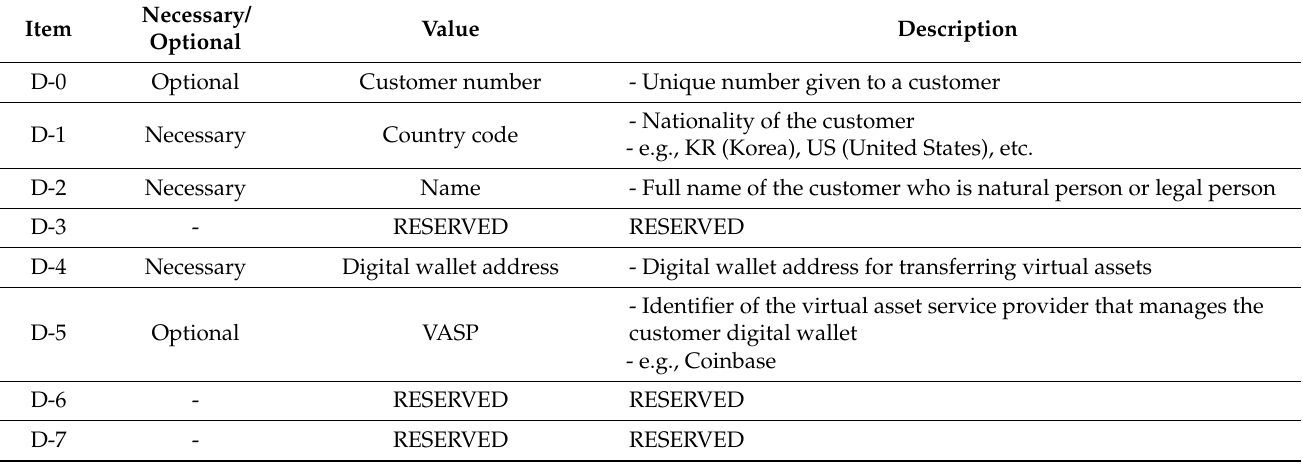
Table 6. Data format-5.